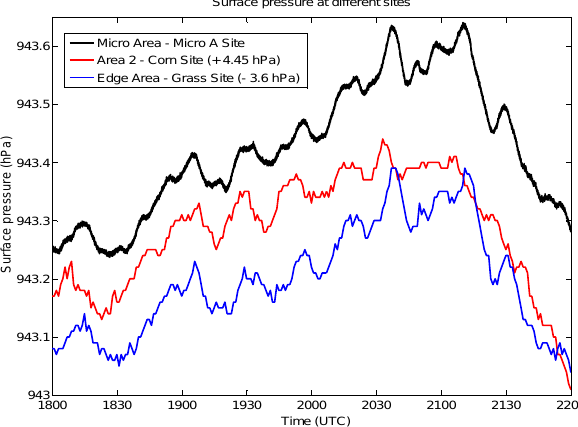
Figure 7. Absolute pressure (hPa) observed at three different sites of BLLAST: micro A site at the micro area (black line), the corn site at the SS2 area (red line, 3.8km S from the micro A site) and the grass site at the edge area (blue line, 1km NNW from the micro A site). Note that 4.45 (3.6)hPa have been added (subtracted) to the original value at the corn site (grass site) in order to compare the